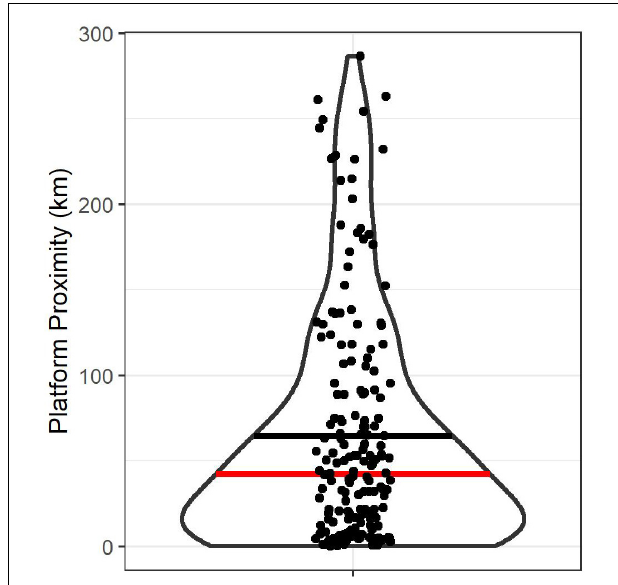
FIGURE 7 | Violin plot of the closest proximity to an oil platform for foraging Leach’s Storm-Petrels breeding at Gull Island, Witless Bay, Newfoundland and Labrador, Canada from 2016 to 2021. The black horizontal line represents the mean proximity (64.7 km) and the red horizontal line is the median (42.7 km).